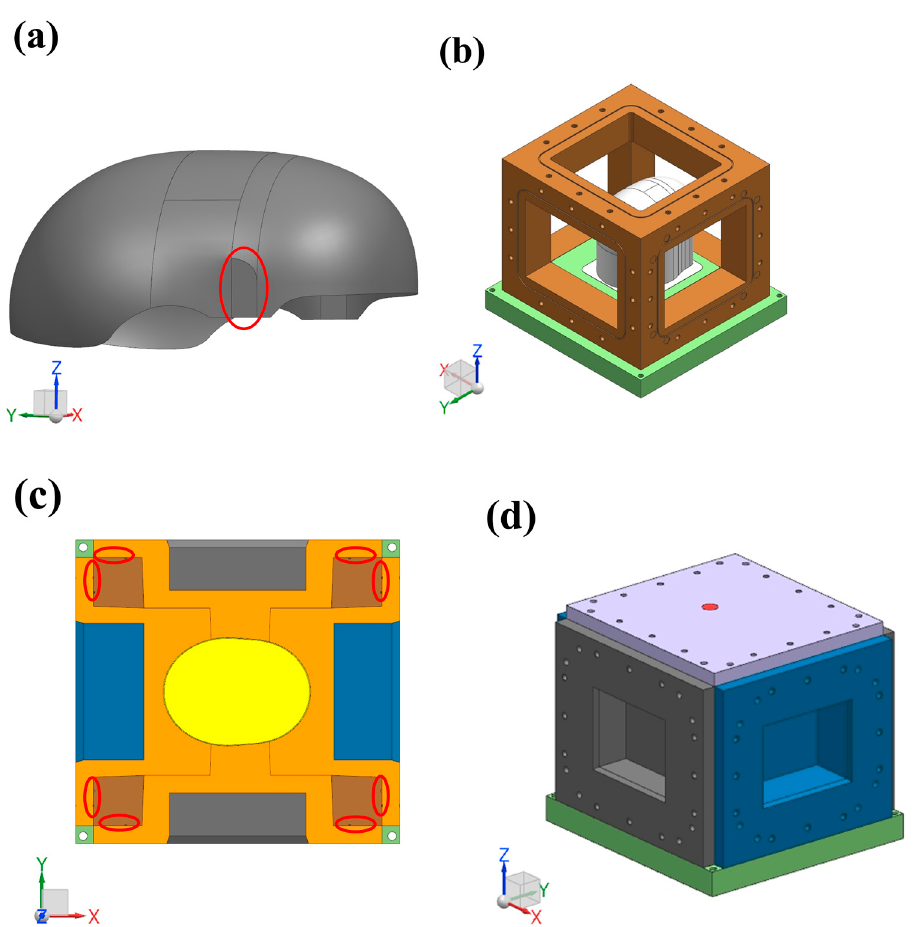
Figure 1. M-CRTM molding process with adjustable injection gap: ( a ) the designed composite helmet model; ( b ) the positioning frame of female molds; ( c ) cross-sectional view of female mold pre-assembly; ( d ) multi-direction compression and locking of the mold.